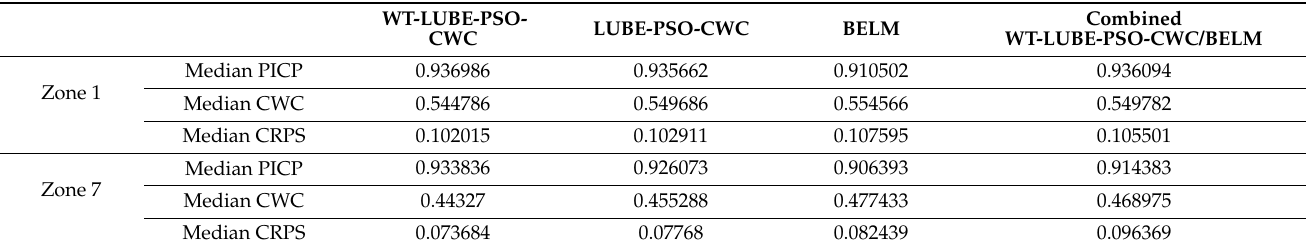
Table 14. Results of the WT-LUBE-PSO-CWC , LUBE-PSO-CWC and BELM models for zone 1 and zone 7 for the year- long